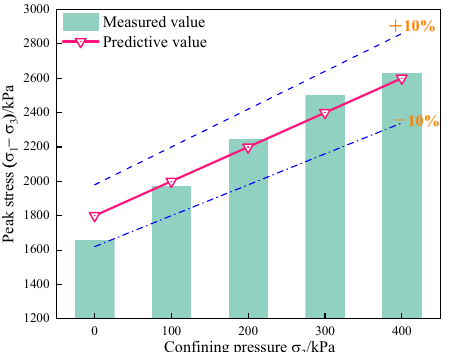
Figure 9. Comparison of the measured and predicted peak intensities with 20% diatomite content.